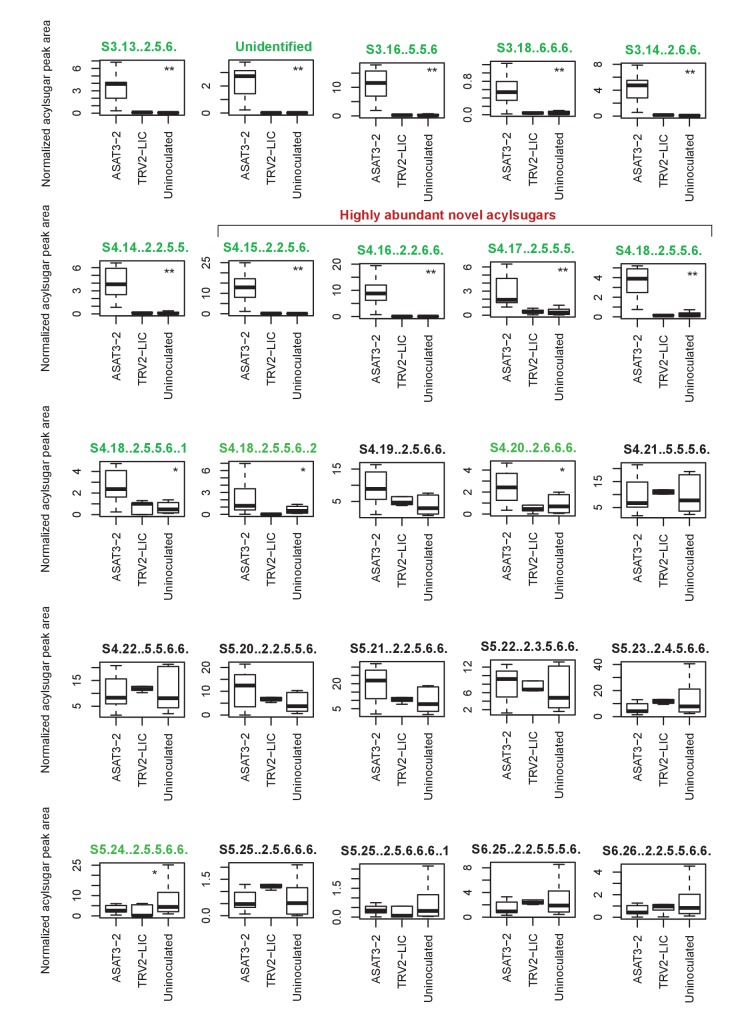
SsASAT3 knockdown boxplots for levels of individual acylsugars.Statistical significance of the difference between TRV2-LIC and ASAT3-2 was tested using Kolmogorov-Smirnov test. ** represents p<0.01 and * represents p<0.05. Boxes where the acylsugars had significantly different levels compared to TRV2-LIC are highlighted in green. Acylsugar peak area was normalized as described in the Methods.